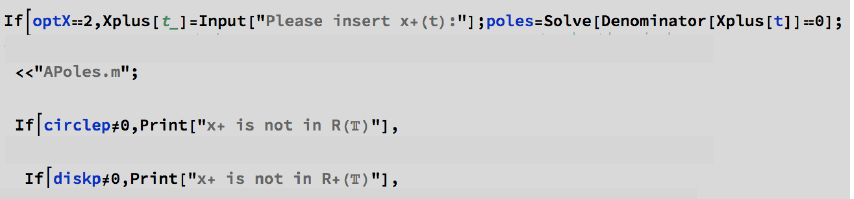
Figure 56. Part of the code structure of the [SInt] 2.0 algorithm responsible for validating x + .